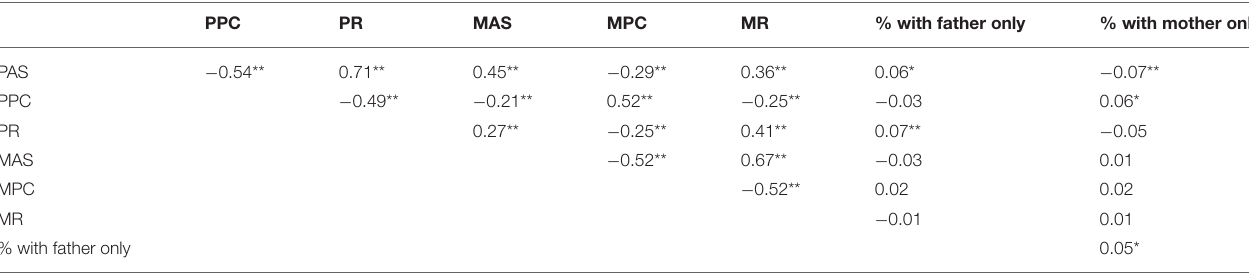
TABLE 2 | Correlations between the six parenting styles and the covariate of time spent with